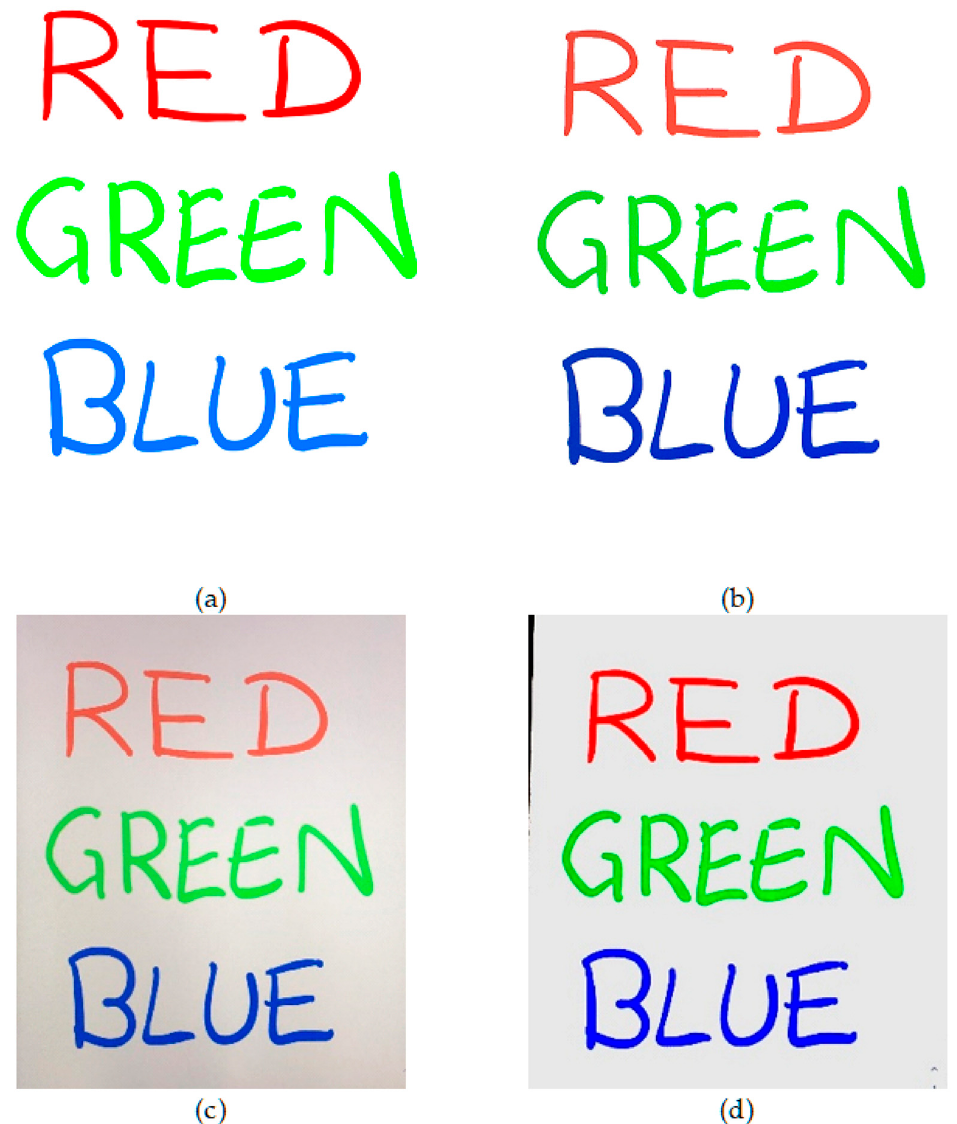
Figure 3. Sample results of an image from the synthesized color image dataset, scanned using a smartphone with the image showing on a tablet screen. ( a ) Original Image; ( b ) CleanPage; ( c ) Google PhotoScan; ( d ) Microsoft Office Lens.